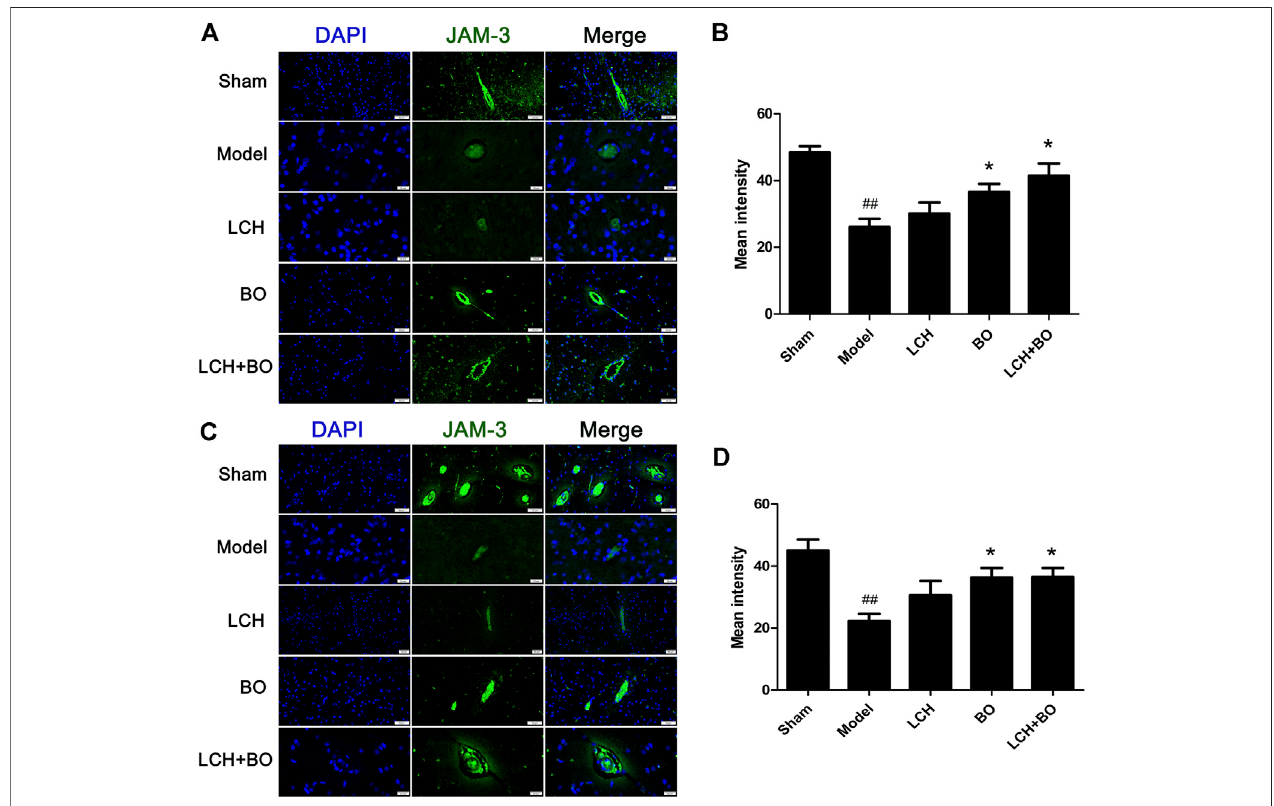
FIGURE 11 | Expressions of JAM-3 within DG and SVZ of MCAO rats. (A) Representative immunostaining images of JAM-3 in the DG area. (B) The results of average fl uorescence intensities of JAM-3 in the DG area ( n (cid:1) 3). (C) Representative immunostaining images of JAM-3 in the SVZ area. (D) The results of average fl uorescence intensities of JAM-3 in the SVZ area ( n (cid:1) 3). ## p < 0.01 compared to the sham group; * p < 0.05 compared to the model